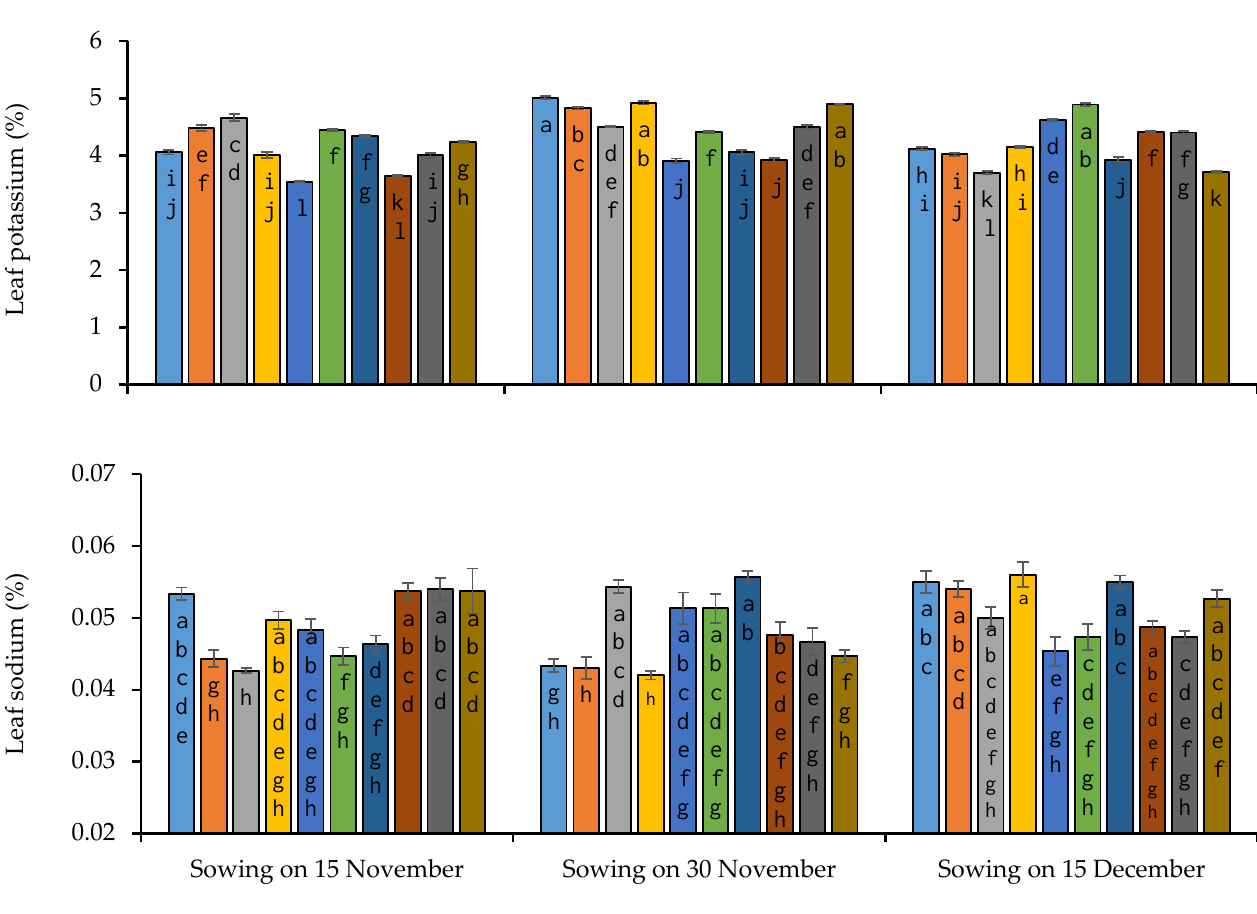
Figure 2. Leaf chlorophyll, leaf protein, leaf potassium and leaf sodium contents of quinoa lines grown under varying sowing dates at anthesis stage on fresh weight basis. Bars sharing the same alphabet did not differ significantly at p < 0.05. Small alphabets (a, b, c. etc.) are used to express the statistically significant difference.